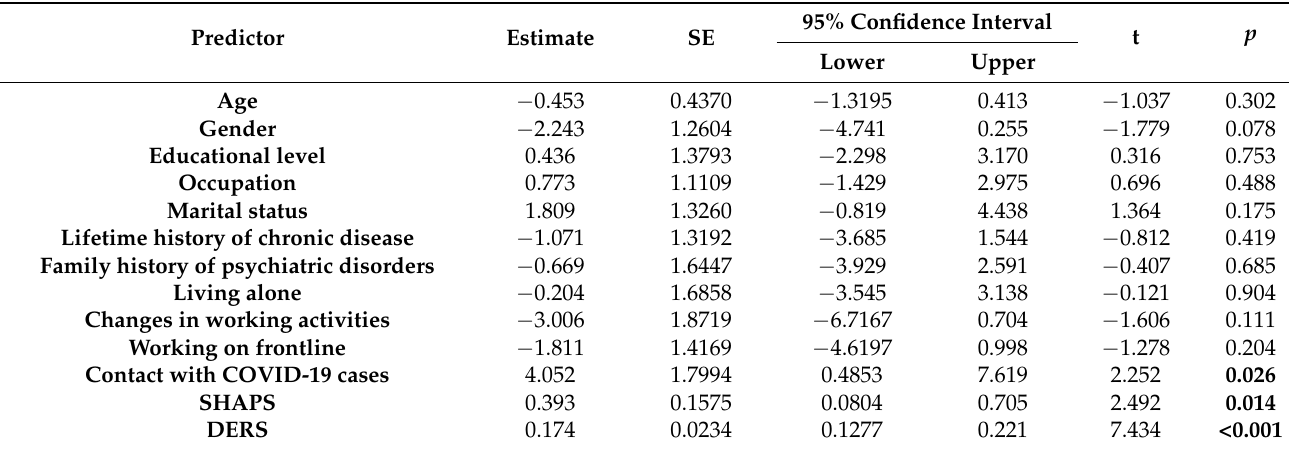
Table 2. General linear model: Effect of predictors on BDI-II total